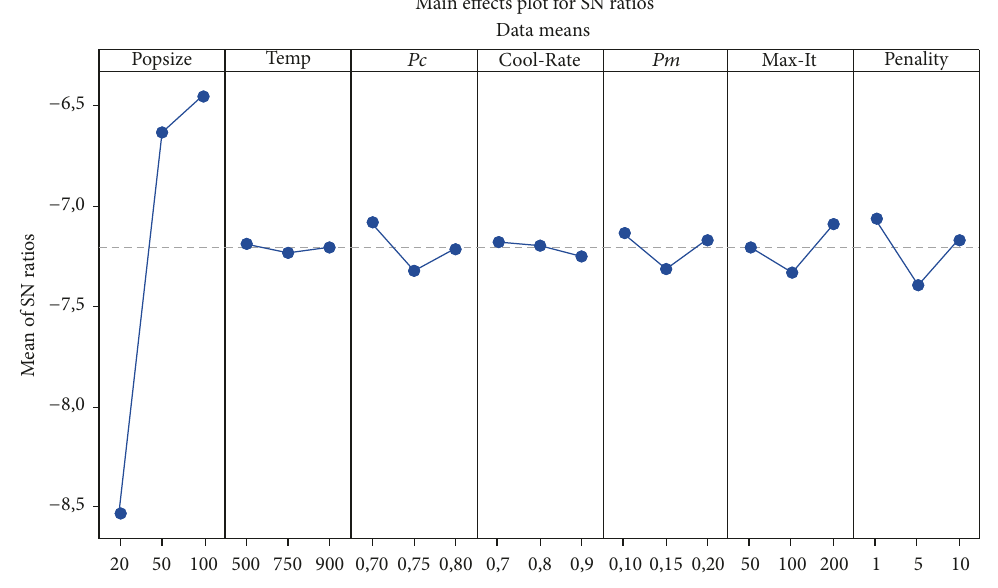
Figure 2: The mean 𝑆/𝑁 plot for each level of the HSAGA